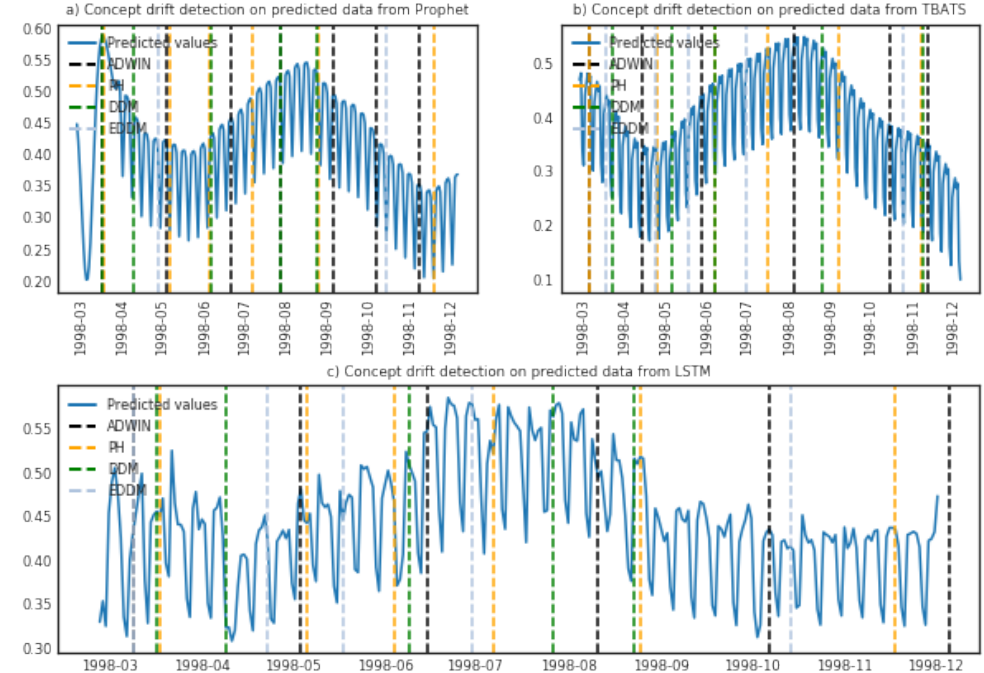
Figure 7. Concept drift detection for ELEC2 [73] dataset, where the X axis shows DateTime and Y axis the value.